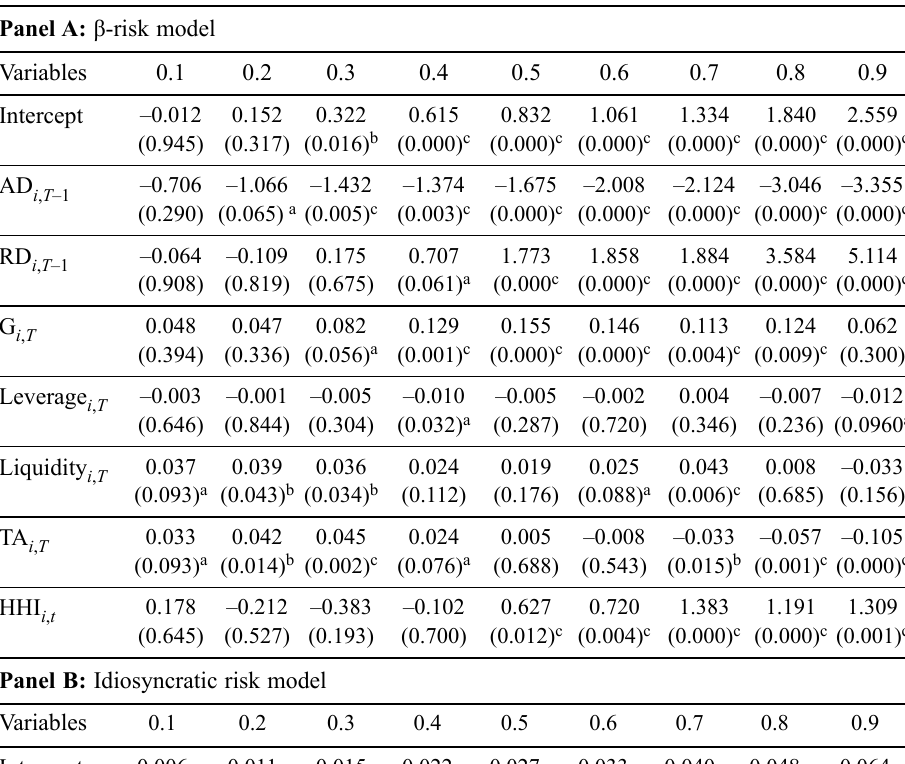
Table 4. Advertising, R&D and risks: results of quantile